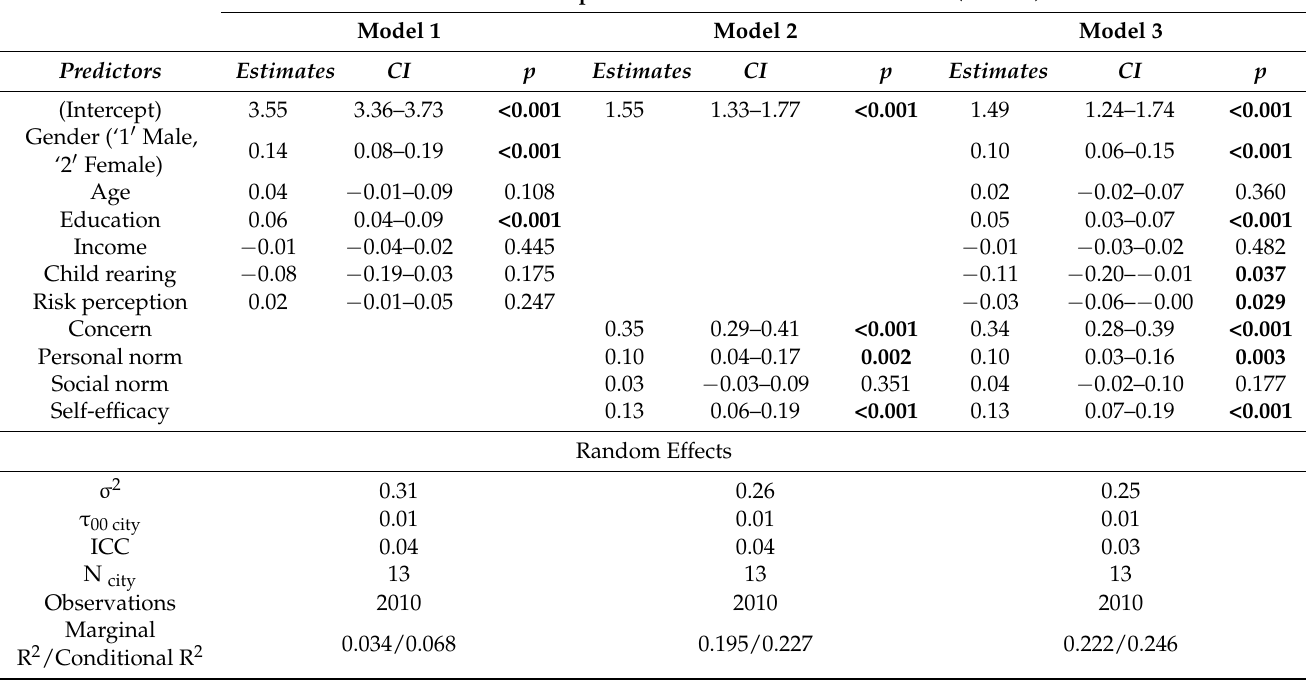
Table 3. Predicting changes in private sphere pro-environmental behaviour to air pollution by demographic variables and social–psychological